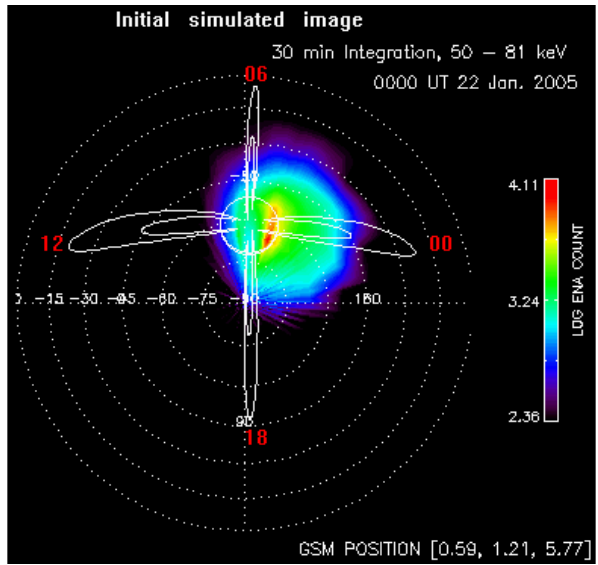
Fig. 5. Initial simulated ENA image displayed using the same for- mat utilized in the left panel of Fig.